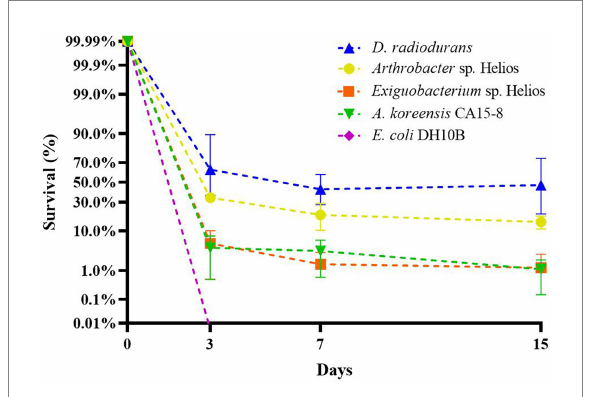
FIGURE 2 Desiccation resistance of Deinococcus radiodurans , Arthrobacter sp. Helios, Arthrobacter koreensis CA15-8 and Exiguobacterium sp. Helios cells in exponential phase of growth in LB medium.